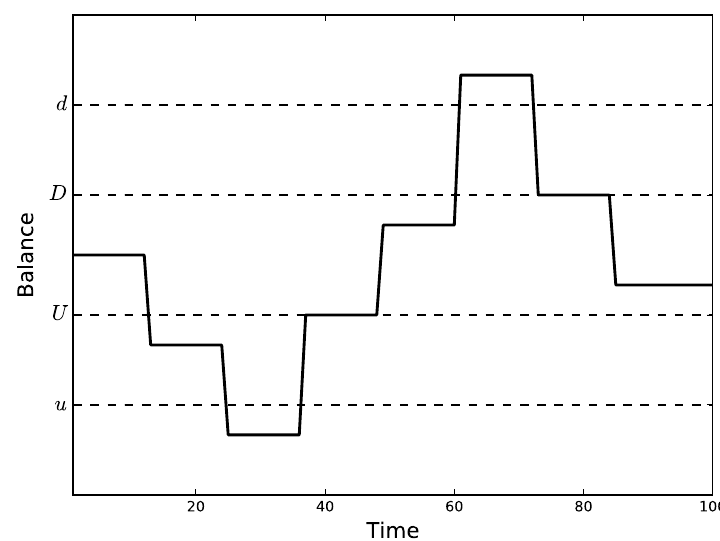
Fig. 4 Eppen‑Fama model representation with two return